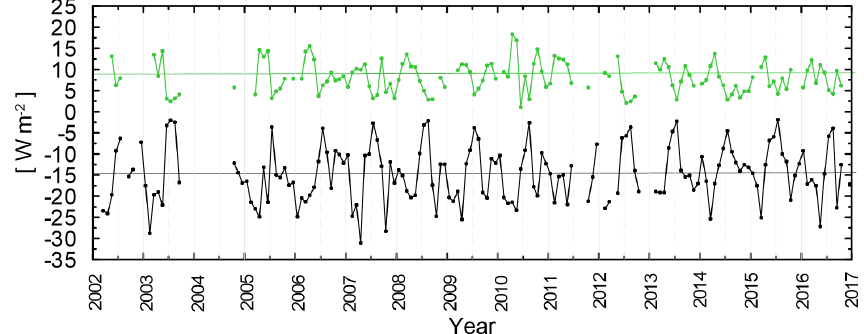
Figure 8. Time series of monthly mean cloud radiative effect for global (black) and diffuse (green) PAR, calculated as the difference between all-sky condition and cloud-free monthly mean PAR (see text). Horizontal lines are mean values of global and diffuse PAR, respectively.